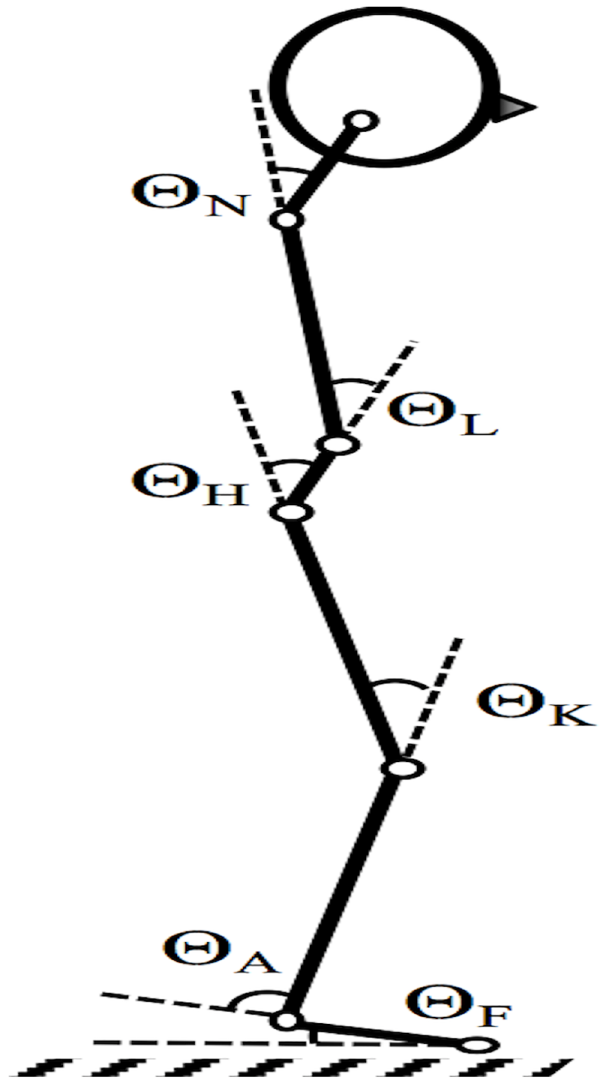
Fig 2. Schematic representation of the defined segment angles. Θ = Neck angle; Θ = Lumbar angle; Θ = Hip N L H angle; Θ = Knee angle; Θ = Ankle angle; Θ = Foot angle; Marker positions (from head to toe): corner of the eye K A F (orbital process of the zygomatic bone), acromion, anterior superior iliac spine, greater trochanter, lateral condyle of femur, lateral malleolus, 1st metatarsal